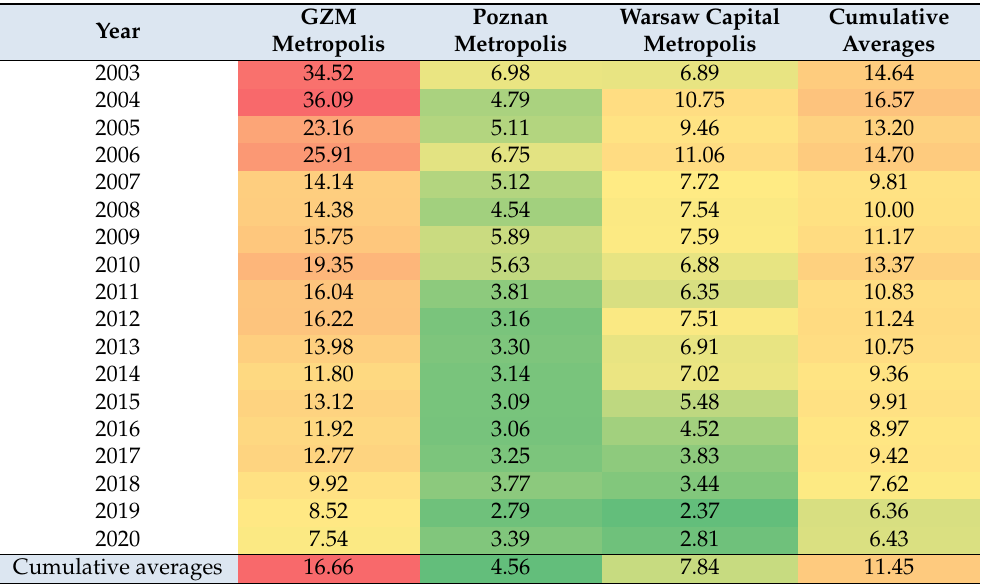
Table 4. The results of SO 2 measurements as averaged annual values provided for three metropolises